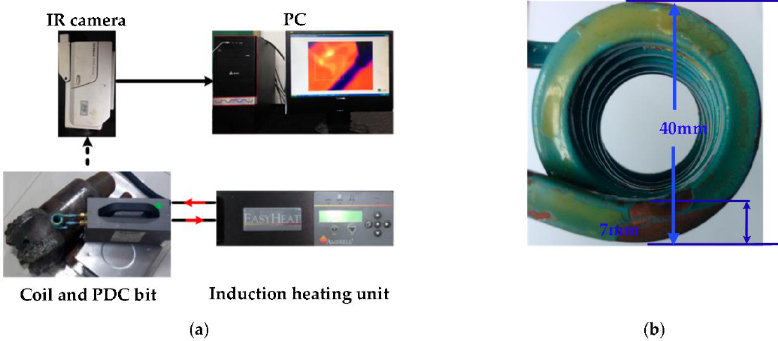
Figure 3. Experimental setup: ( a ) each part of the experimental system; ( b ) zoomed view of the excitation coil.